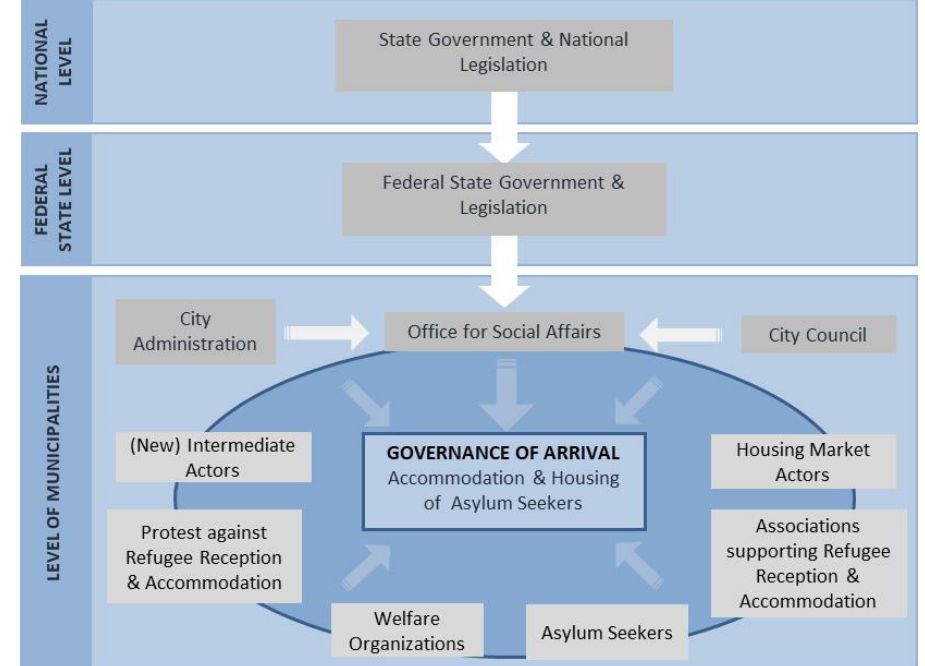
Figure 3. Governance of arrival. Source: authors’ own